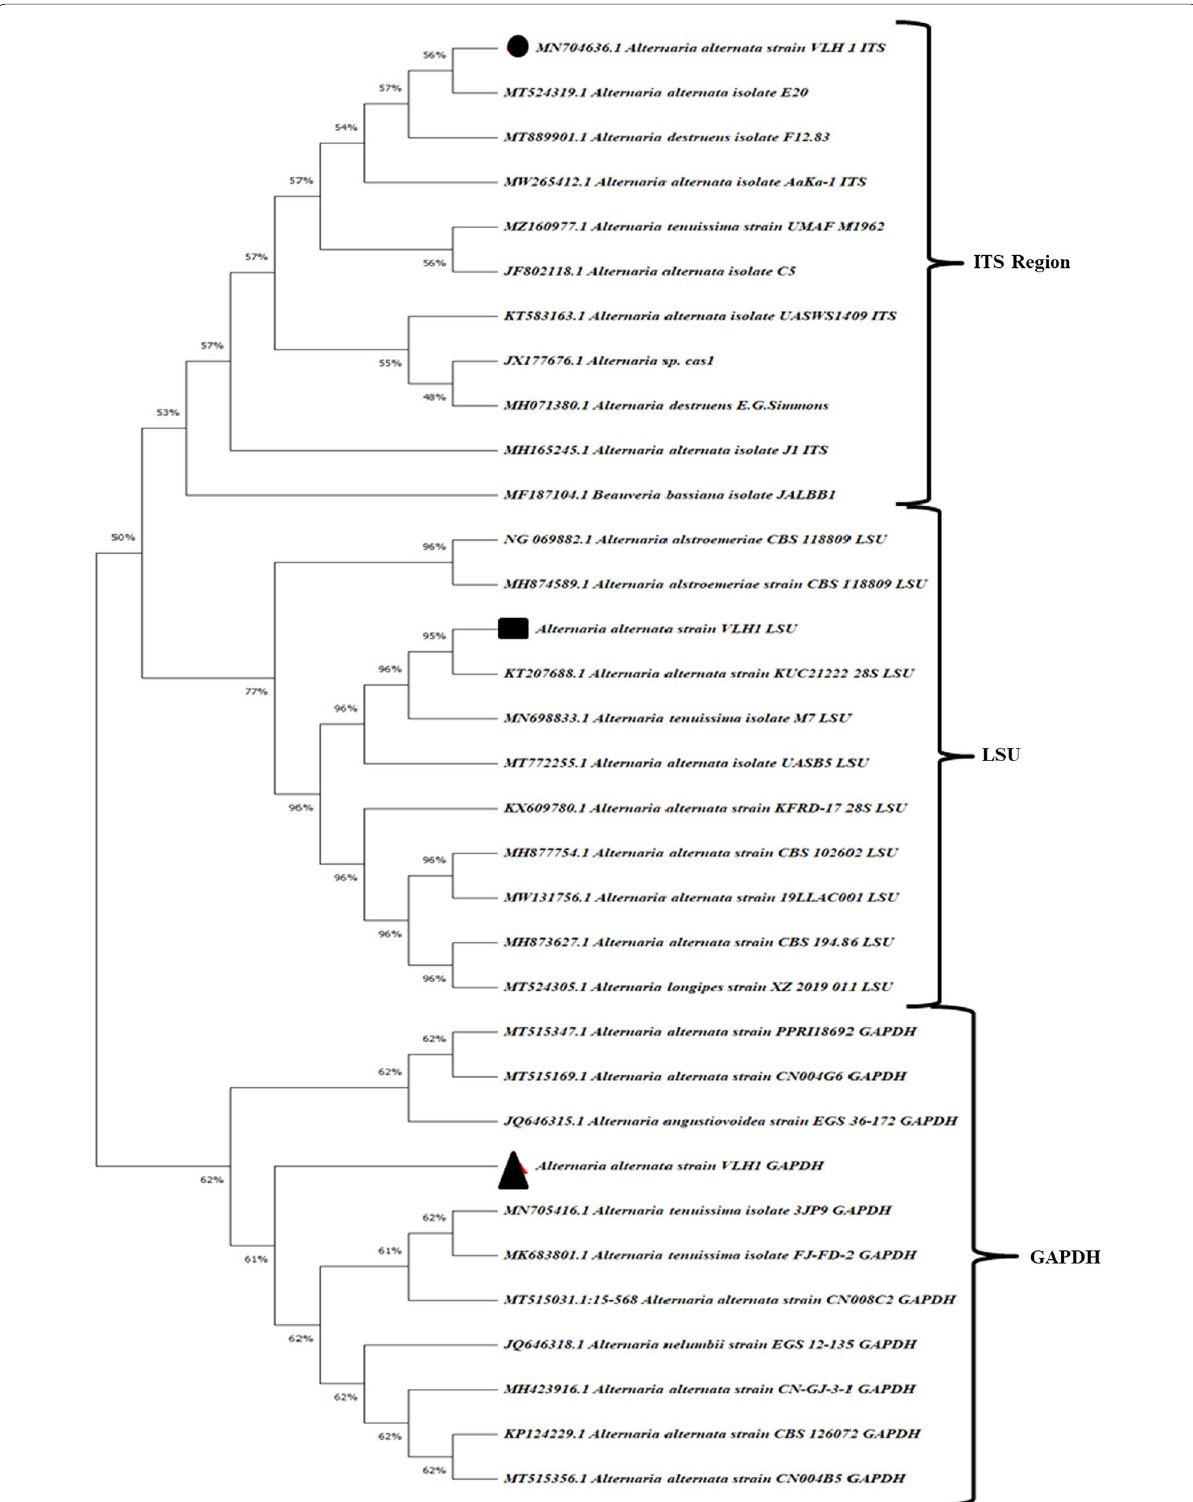
Fig. 2 Phylogenetic analysis of Alternaria alternata VLH1 along with 33 closely associated Alternaria species sequences ( Beauveria bassiana isolate JALBB1 is taken as out-group). Filled circle: A. alternata VLH1 ITS region, filled square: A. alternata VLH1 LSU region, filled triangle: A. alternata VLH1 GAPDH